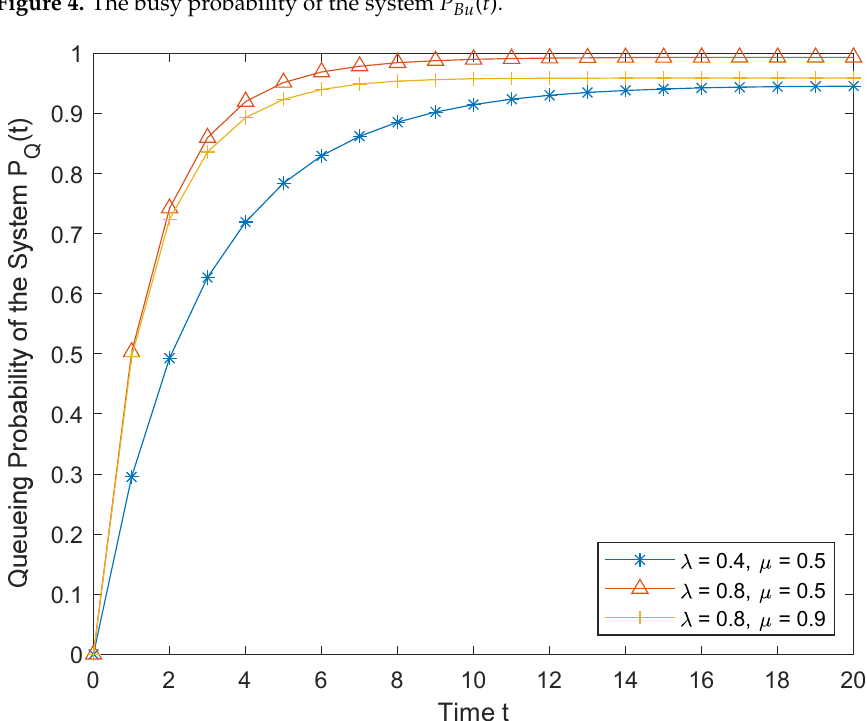
Figure 5. The queueing probability of the system P Q ( t ).